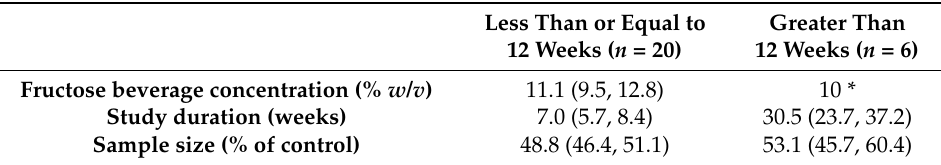
Table 2. Summary statistics (mean (95% CI)) of fructose beverage concentration (% w / v ), study duration and sample size (as a percentage of control) split for study duration ( ≤ 12 weeks or >12 weeks).